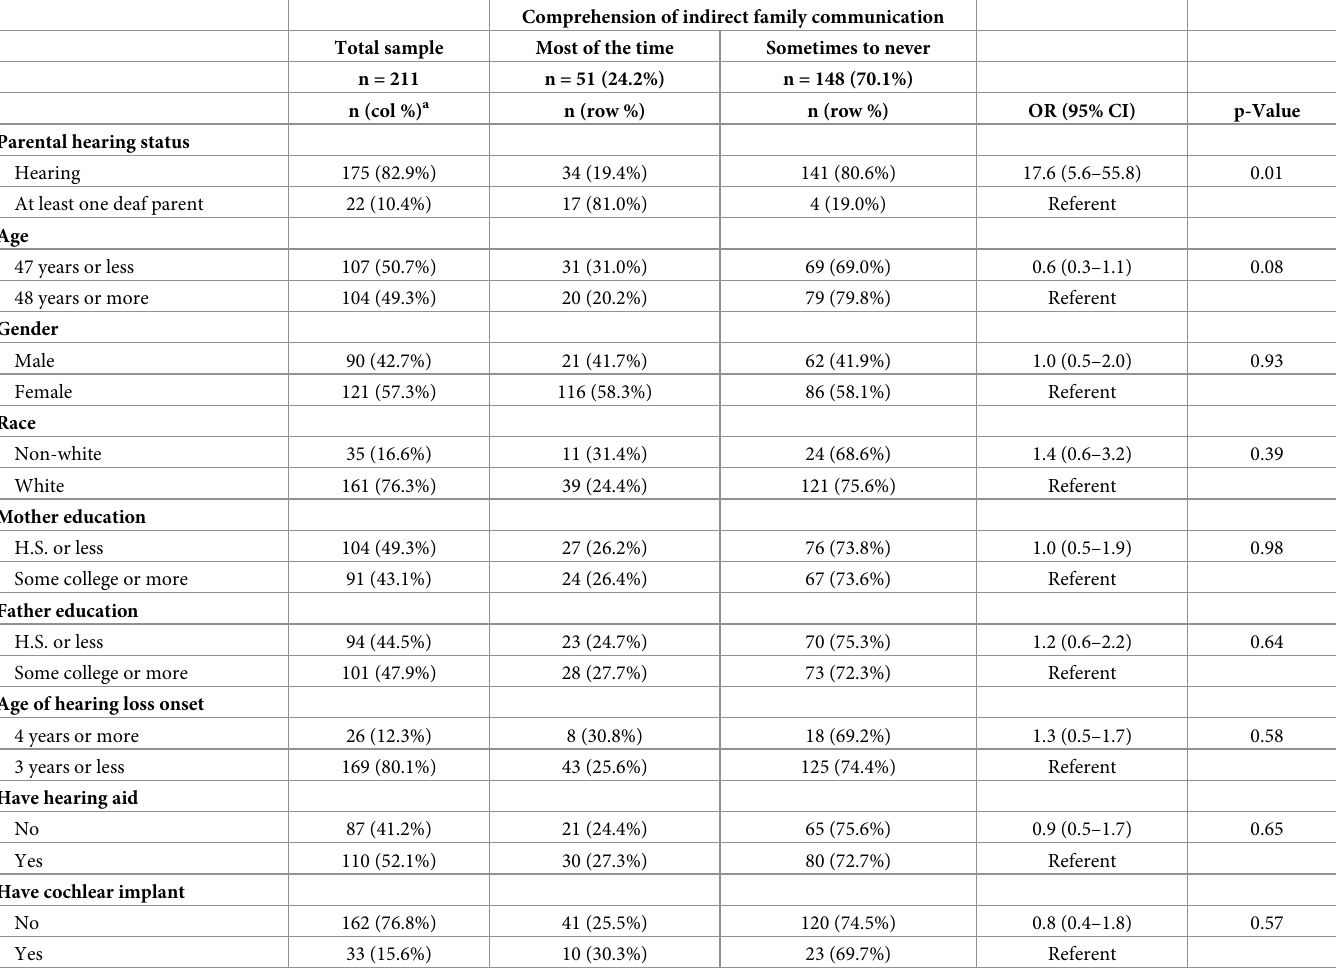
Table 1. Relationships between parental hearing status and other demographic factors with comprehension of indirect family